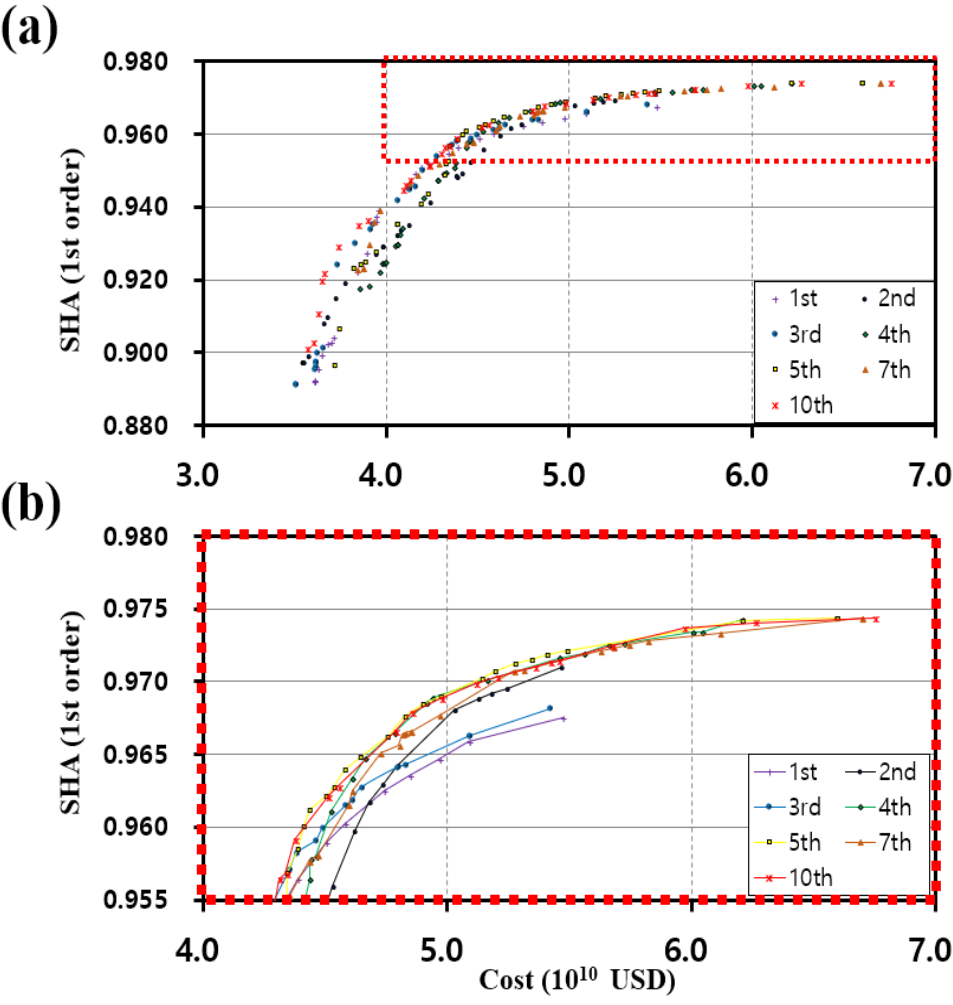
Figure 2. (a) Pareto-optimal solutions in mechanical redundancy-based design considering different pipe failure orders, (b) Enlarged view of the distribution of solutions around the marginal cost